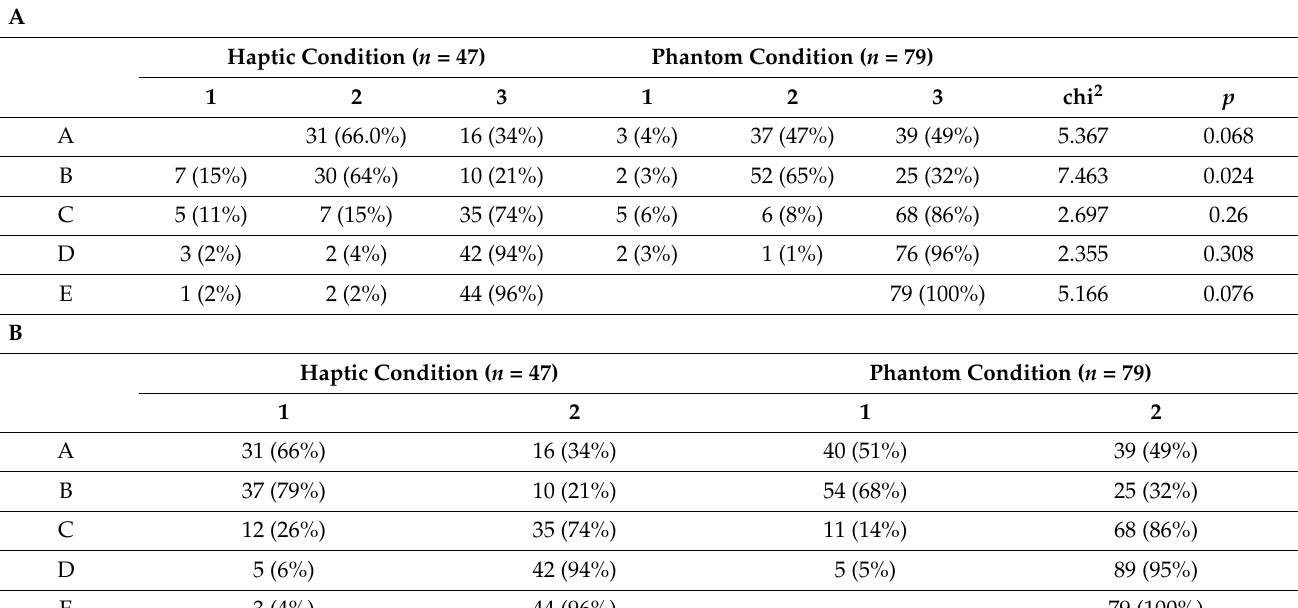
Table 5. A: Comparison of performance on individual criteria ( n = 126, Study 2). B: Re-coded comparison of performance on individual criteria ( n = 126, Study